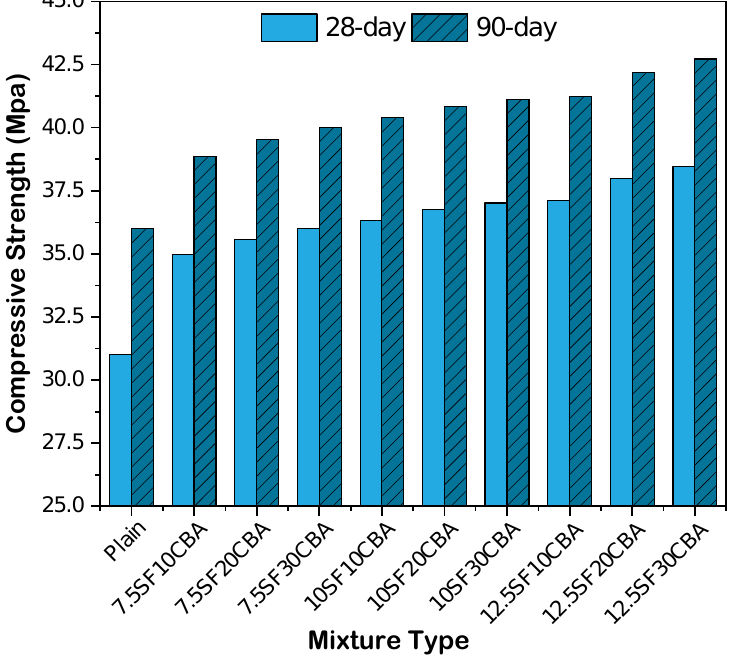
Figure 7. Compressive strength of concrete mixed CBA and SF.